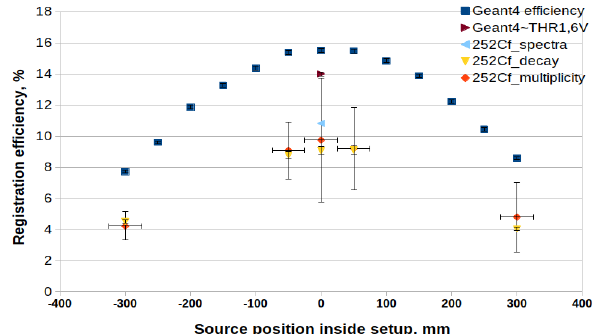
Fig. 6. Comparison of neutron detection efficiency obtained by measurement with 252 Cf and Geant4 calculation. Nine neutron counters were placed in the inner layer moderator blocks (fig.